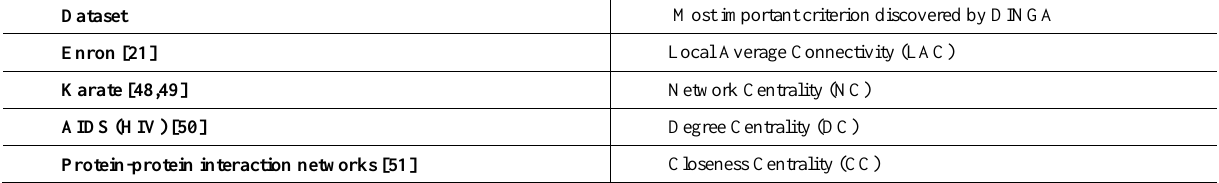
Table 2. Discovery of the most efficient graph criteria in each graph by the DINGA